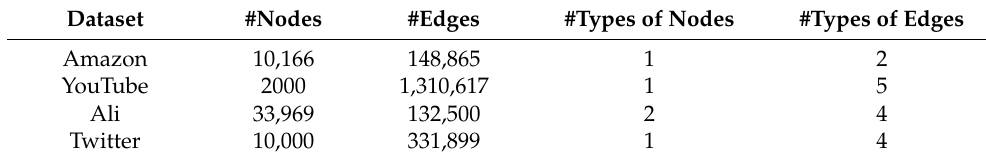
Table 2. Statistics of datasets used in